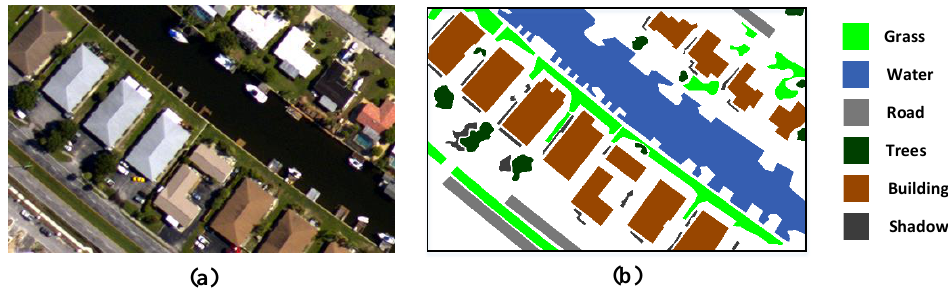
Figure 7. Aerial data: ( a ) Image data. ( b ) Available ground-truth.